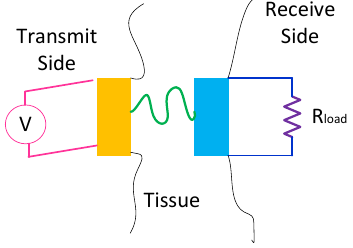
Figure 24. The UTET structure.